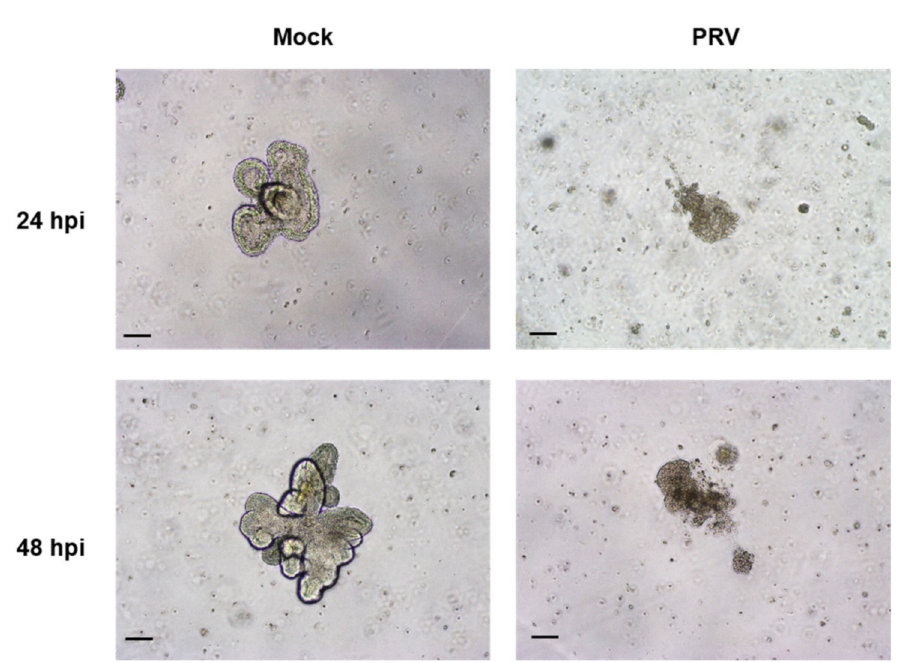
Figure 6. Representative phase-contrast images of mock-infected (Mock) and PRV-infected organoids (PRV). The upper and lower were 24 and 48 hpi, respectively. Scale bar: 200 µ